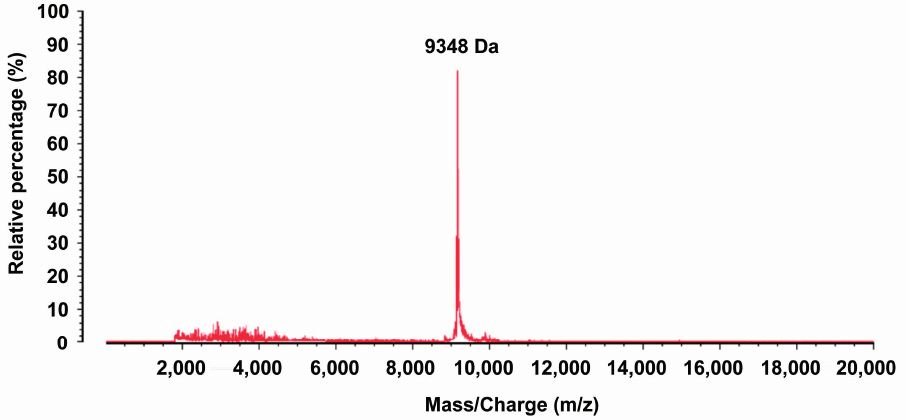
Figure 4. Isolation and purification of the proteins or peptide segments with an m / z of 9348 Da by HPLC. MALDI-TOF-MS confirmed that the sample eluted at minutes 36 and 37 contained the proteins with an m / z of 9348